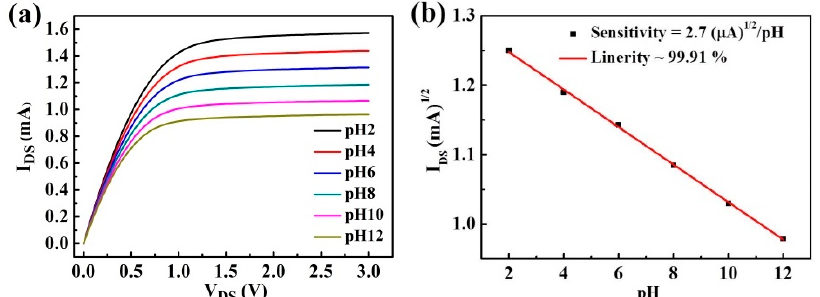
Figure 6. ( a ) I DS -versus- V DS curve under various pH buffer solutions. ( b ) Linearity of the I DS of TiO 2 EGFET sensor. Table 1. Comparison of other metal oxide-based extended gate field effect transistor (EGFET) pH sensors.